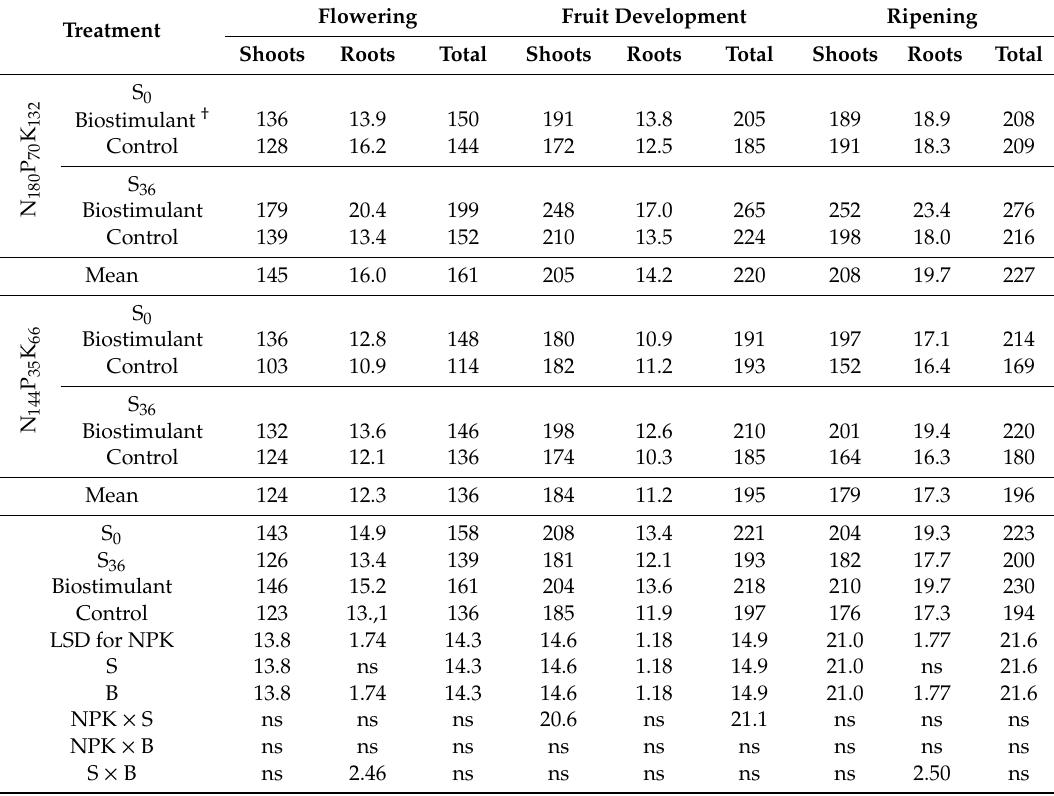
Table3. Uptakeofnitrogeninshootsandrootsofrapeseedinconsecutivegenerativedevelopmentstages depending on mineral fertilization rates and biostimulant application, mean from 2011–2013 (kg ha − 1